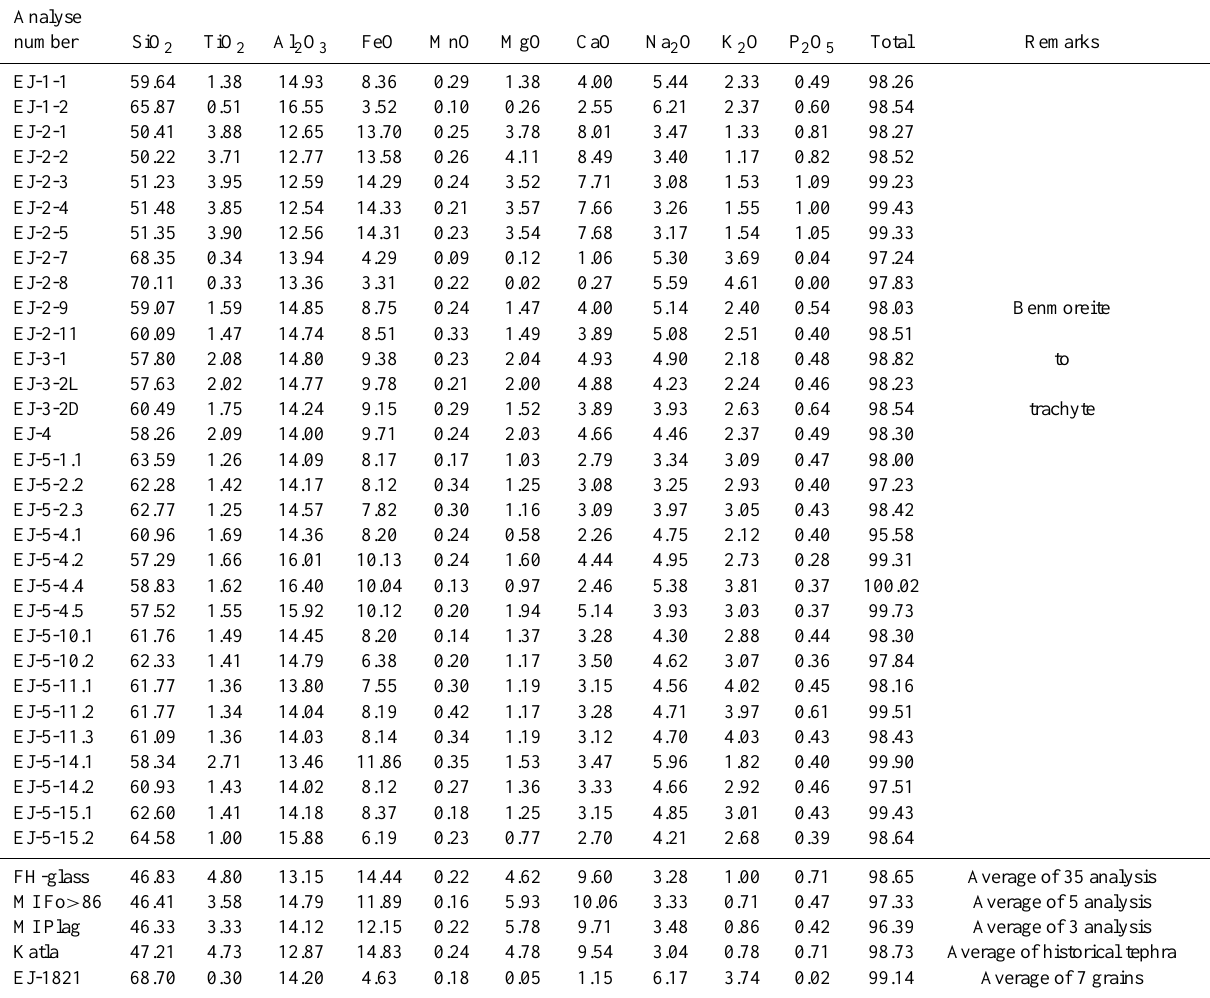
Table 2. Electron probe microanalysis of glasses in Eyjafjallajökull’s tephra.